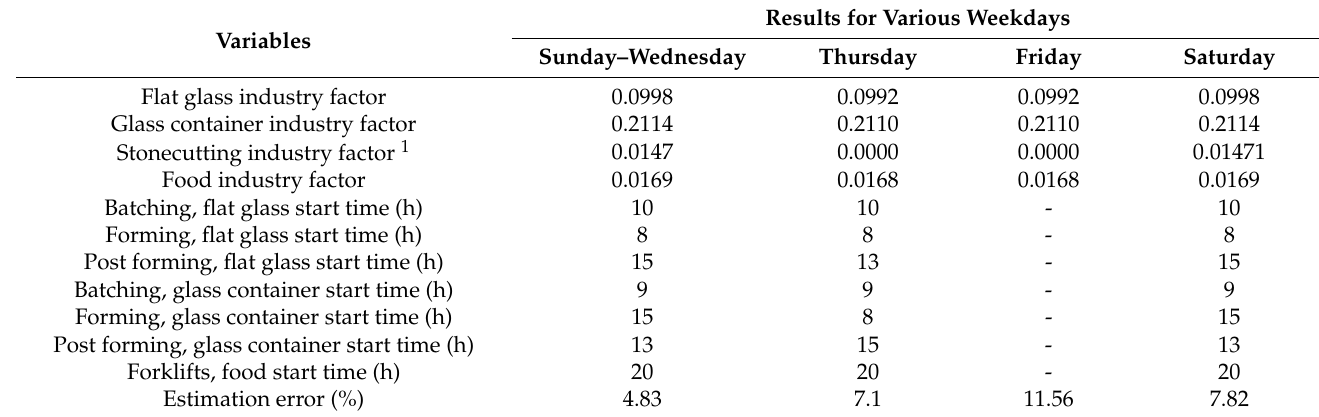
Table 14. The optimum value of the variables for various weekdays in a spring week.